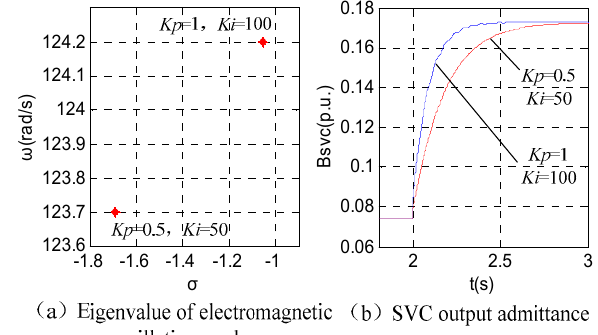
Figure 10. Eigenvalue of the electromagnetic oscillation mode and admittance step response of the SVC under different PI parameters .